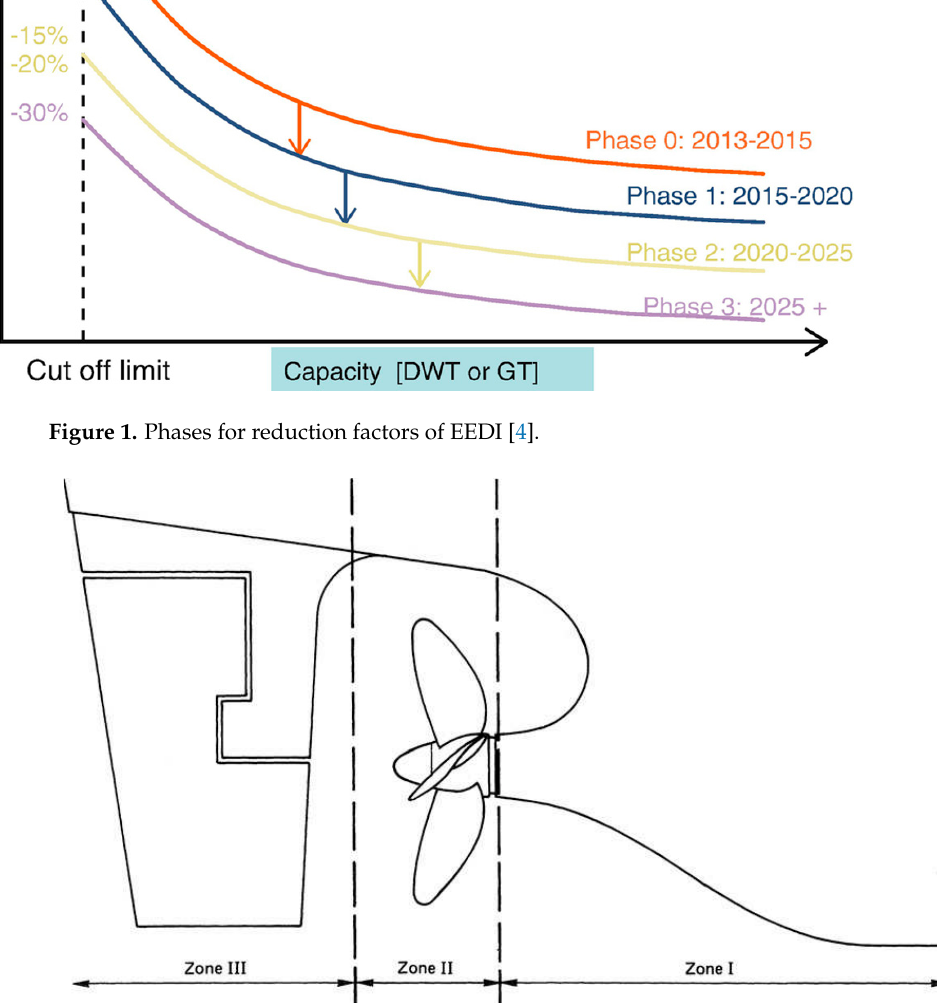
Figure 2. Classification of ESD [6]. Republished with permission from Carlton, J. S., Marine Propellers and Propulsion; published by Elsevier Science & Technology Journals, 2012.